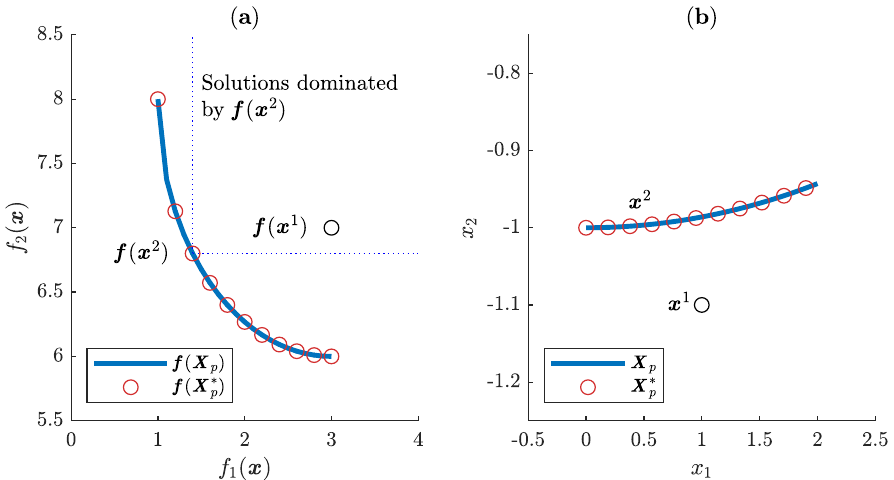
Figure 4. ( a ) Pareto front f ( X p ) for a bi-objective multi-objective optimisation problem (MOOP); and ( b ) the Pareto set X p in the decision space. f ( X ∗ p ) and X ∗ p represent a possible characterisation of f ( X p ) and X p ,